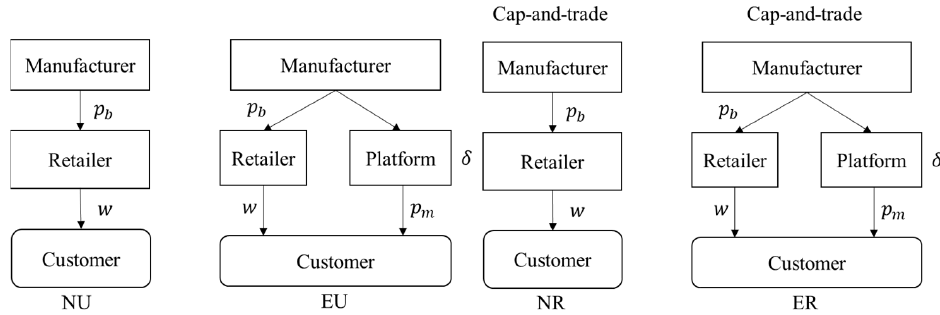
Figure 1. channel and low-carbon regulation scenarios. Figure 1. Channel and low-carbon regulation